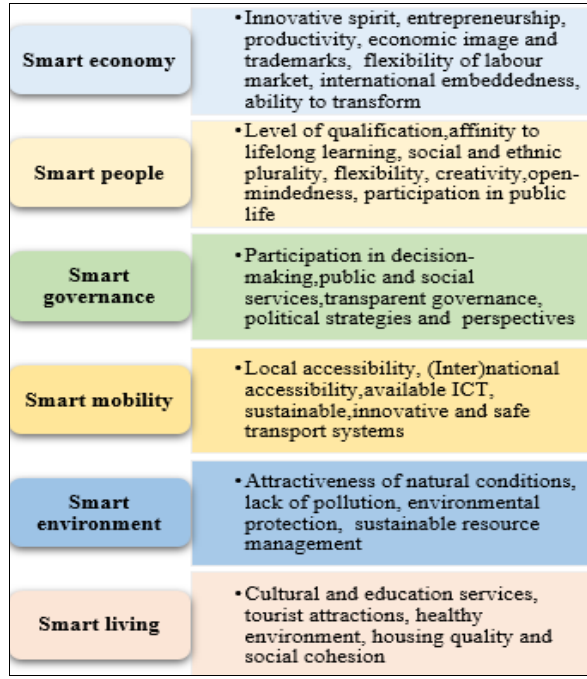
Figure 1 . Smart city